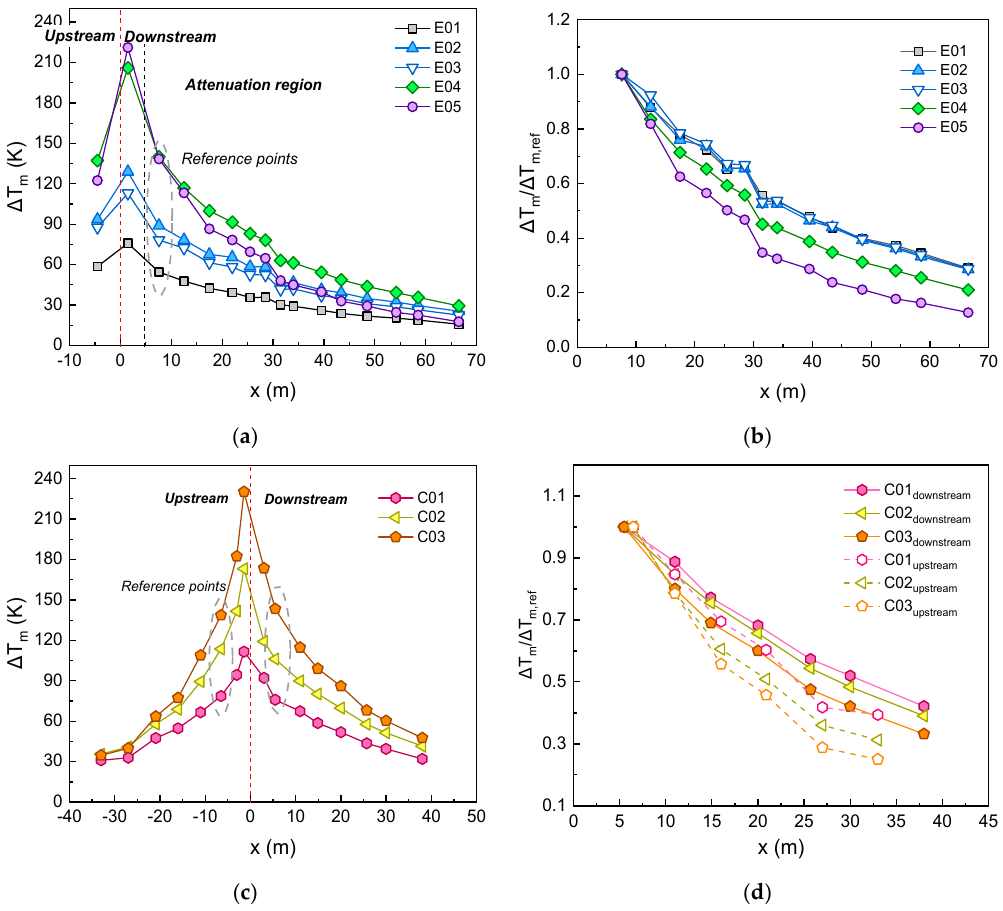
Figure 17. The longitudinal distribution of maximum gas temperature along the tunnel: ( a ) temperature distribution in Test E01–05; ( b ) dimensionless temperature distribution in Test E01–05; ( c ) temperature distribution in Test C01–03; ( d ) dimensionless temperature distribution in Test